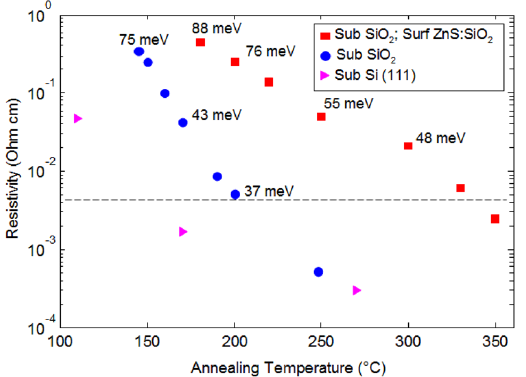
Figure 8. Resistivity measured at room temperature in samples prepared with different interfaces, as a function of annealing temperature. The dashed line indicates the value of 5 mOhm cm. The energy values indicated in the figure are the mobility gaps, obtained from the temperature variation of resistance in the range 40–100